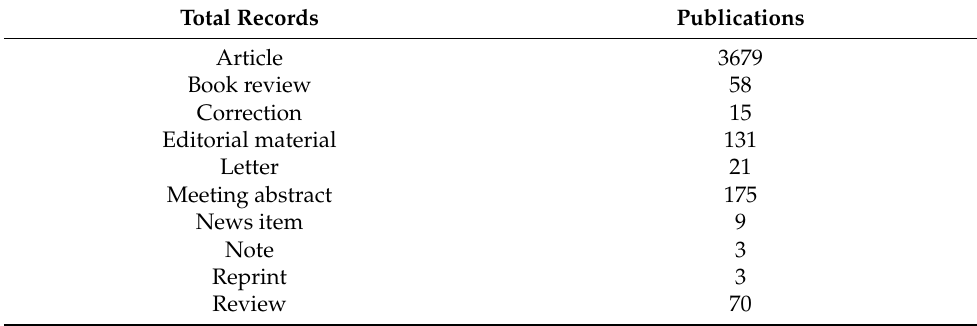
Table 1. Literature parameters of the combined output from WOS and Scopus.